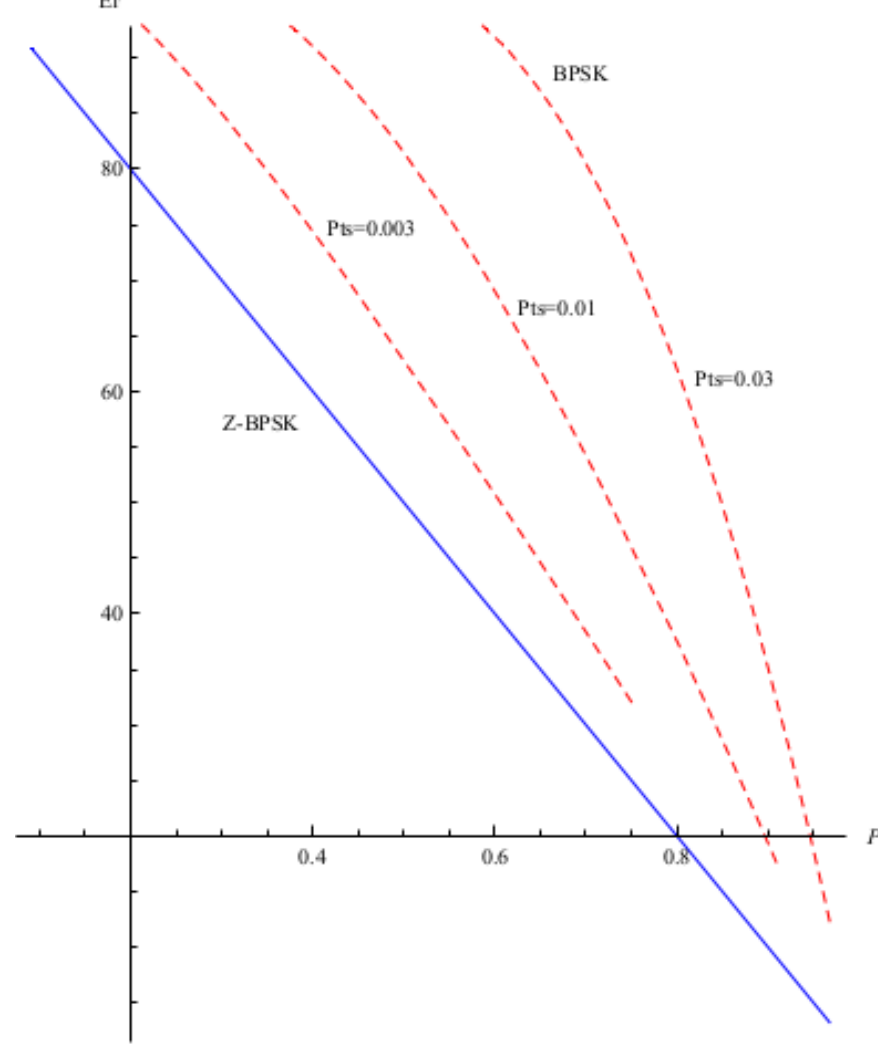
Figure 8. Average energy per frame E f of the Z-BPSK (solid line) and BPSK (dashed line) as a function of the probability of zero symbol emission P 0 for different values of the probability of transition from talk to silence state P TS